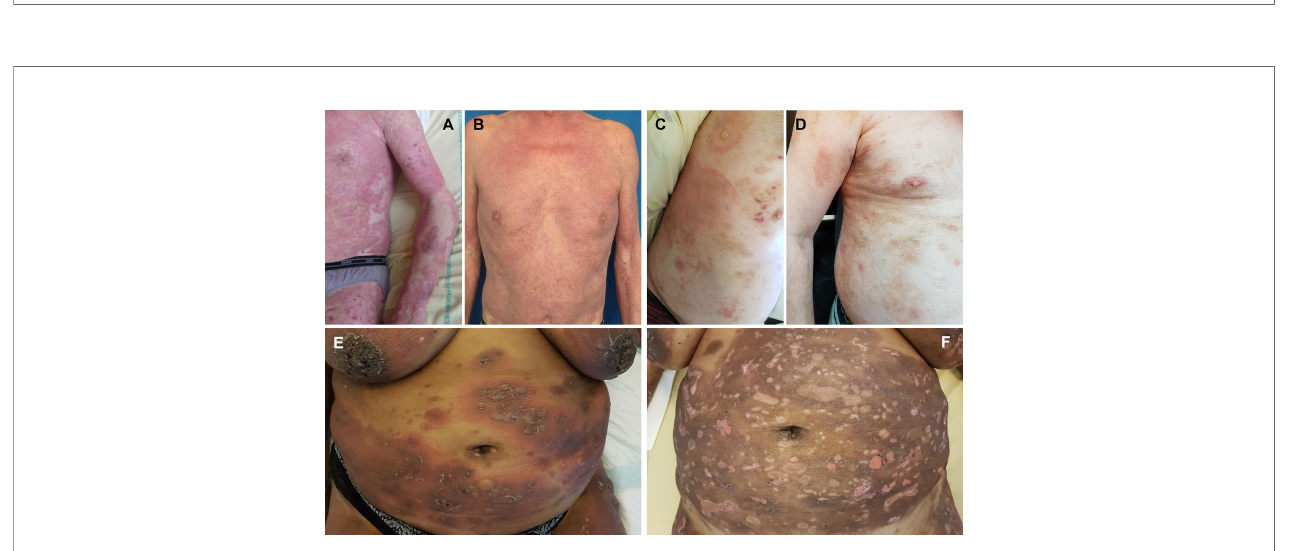
FIGURE 3 | Clinical improvement during omalizumab therapy. Case #2 at baseline (A) and day 15 (B) ; case #9 at baseline (C) and day 30 (D) ; case #11 at baseline (E) and day 30 (F)